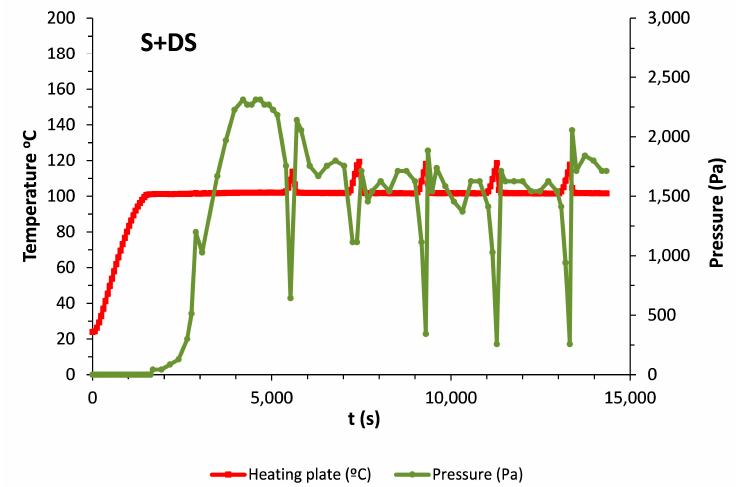
Figure 19. Plate temperature and pressure in the S+DS porous medium: z = 3.364 cm to the heating plate, piezometer 4.